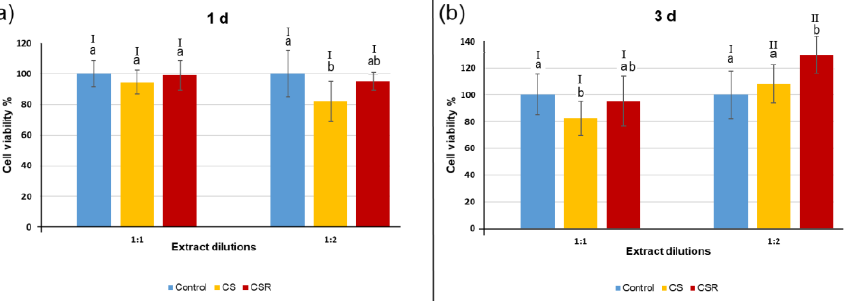
Figure 6. Cell viability results of CS and CSR after incubation with the materials’ extracts for 1 d ( a ) and 3 days ( b ) at two different dilutions 1:1 and 1:2. Different lowercase letters indicate significant difference between groups within each dilution, p < 0.05, while Roman numbers I, II indicate difference between dilutions of each group within each time point, p < 0.05.